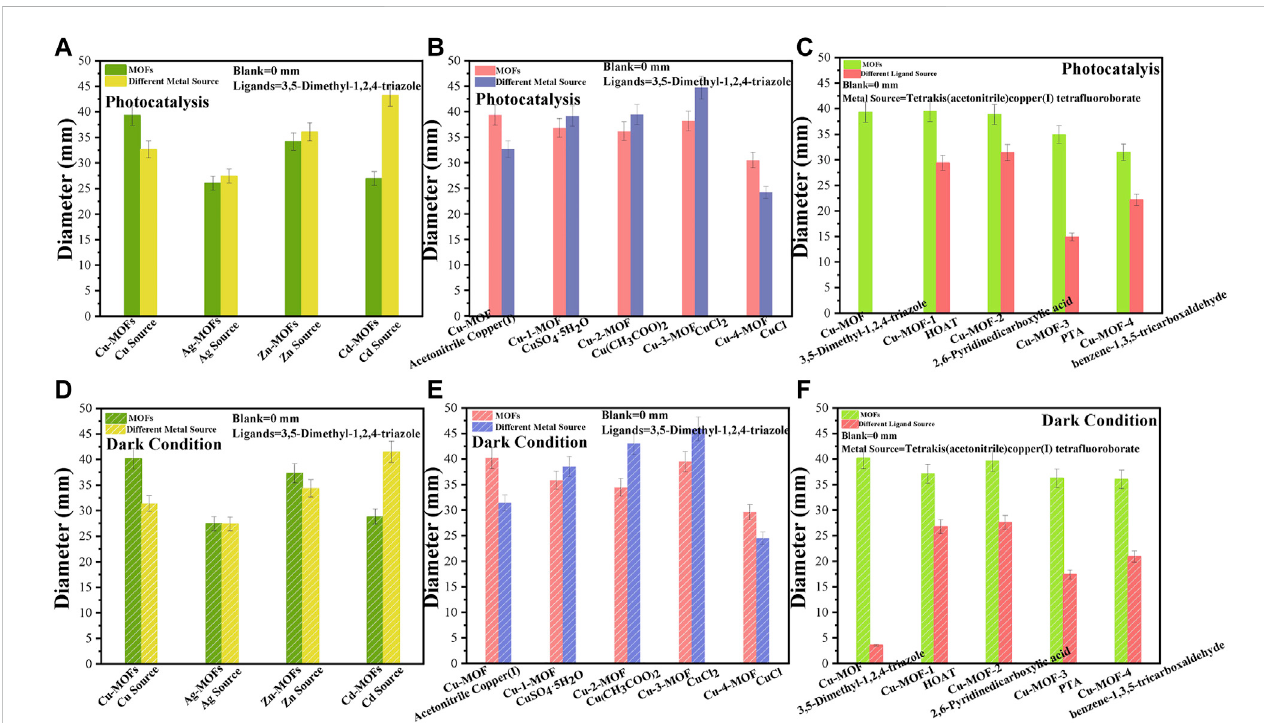
FIGURE 5 The zone of inhibition test of Cu-MOFs, Ag-MOFs, Zn-MOFs, and Cd-MOFs with their metal sources under (A) photocatalysis and (B) dark condition, of Cu-MOF, Cu-1-MOF, Cu-2-MOF, Cu-3-MOF and Cu-4-MOF with different metal sources under (C) photocatalysis and (D) dark conditions, and of Cu-MOF, Cu-MOF-1, Cu-MOF-2, Cu-MOF-3, and Cu-MOF-4 with different organic ligands under (E) photocatalysis and (F) dark conditions, in nutrient agar plates inoculated with a bacterial suspension of S. aureus